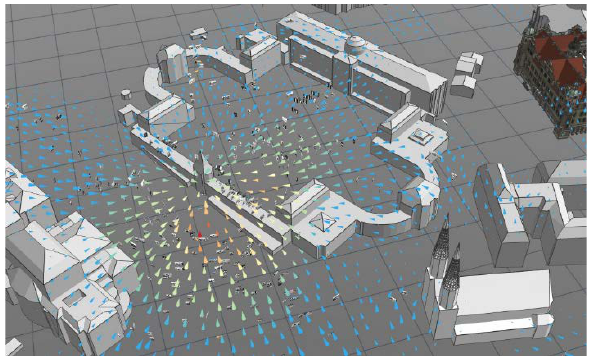
Figure 7. Vector field, visualizing the average acquisition angle